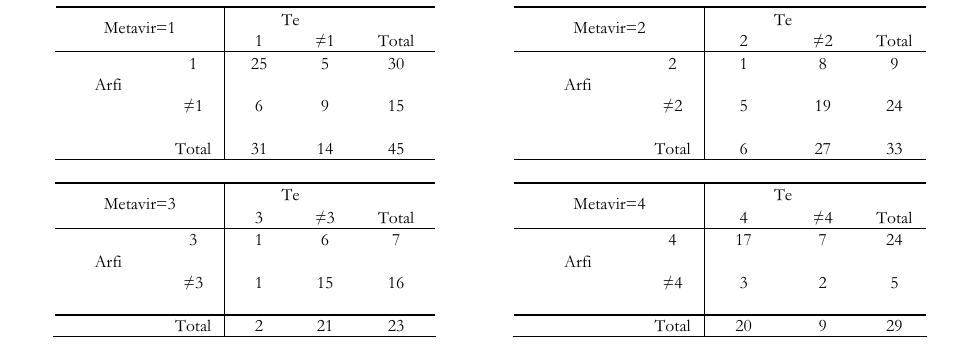
Concordance/Discordance tables of TE vs ARFI conditioned to